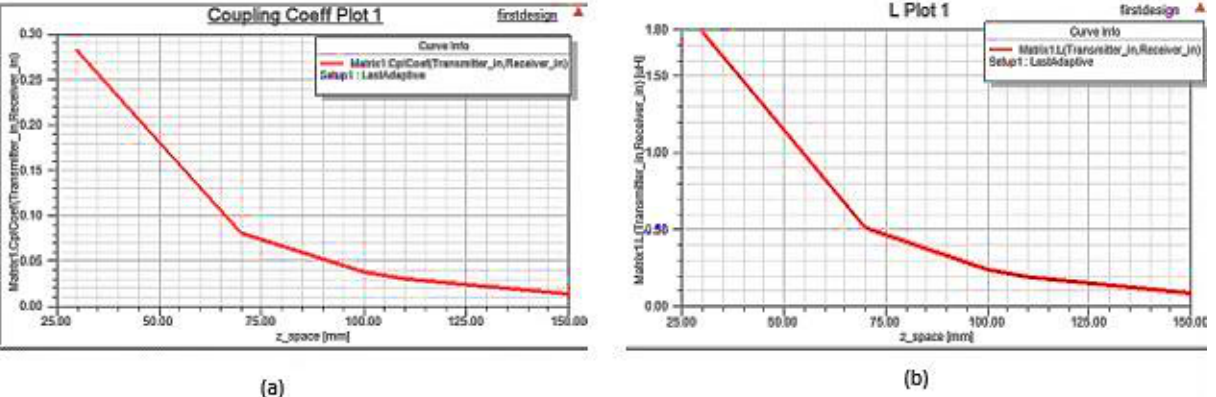
Figure 7. Results for 120 mm spiral coil: ( a ) mutual inductance vs. air gap spacing (mm), ( b ) coupling coefficient vs. air gap spacing (mm).